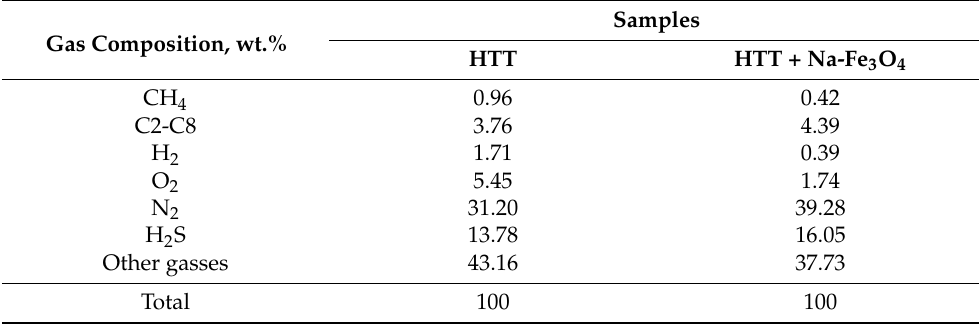
Table 2. The Gas Composition of the experimental products. Gas Composition,